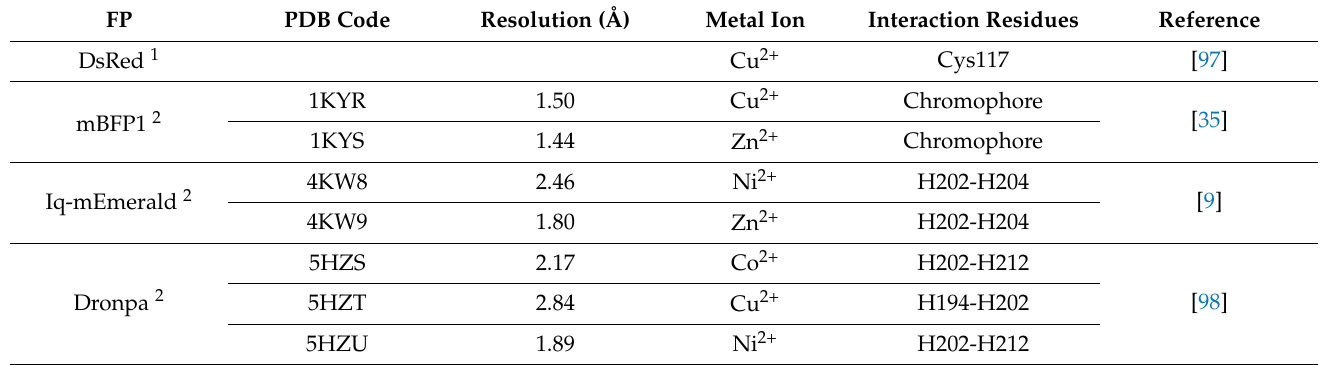
Table 5. Metal-binding site of metal-induced fluorescence quenchable fluorescent